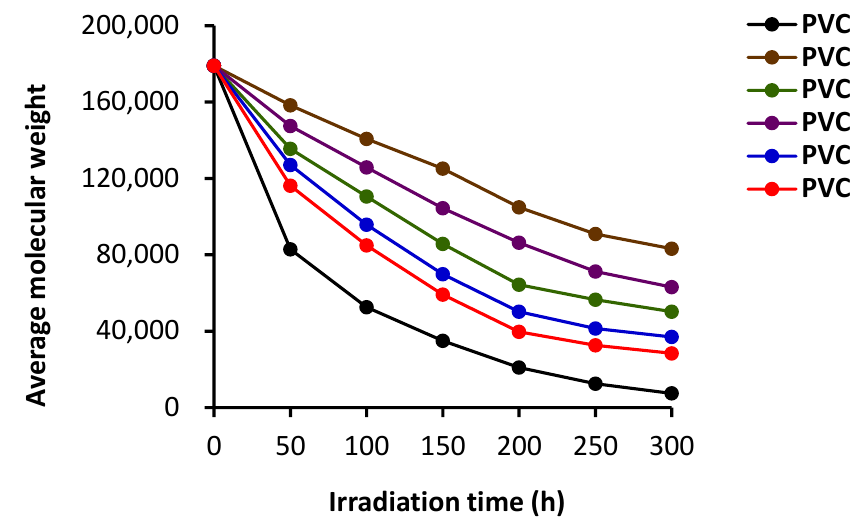
Figure 8. The Mv of the irradiated PVC films.